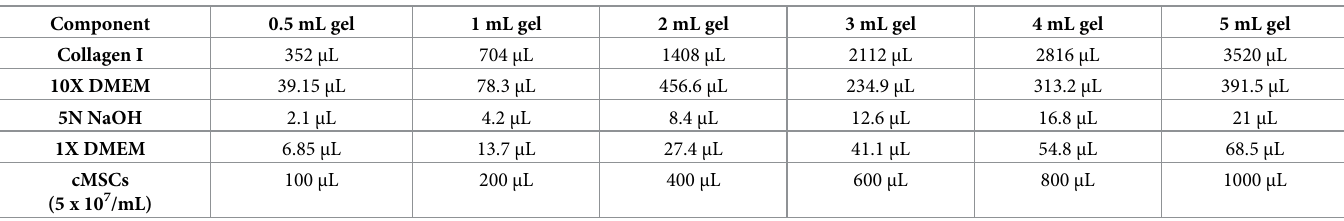
Table 1. Three-dimensional (3D) Collagen Type I gel formula (5 mg/mL). Component